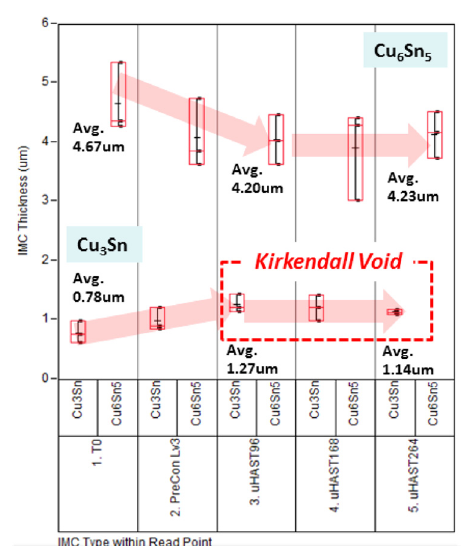
Figure 9. IMC growing thickness under uHAST stress test